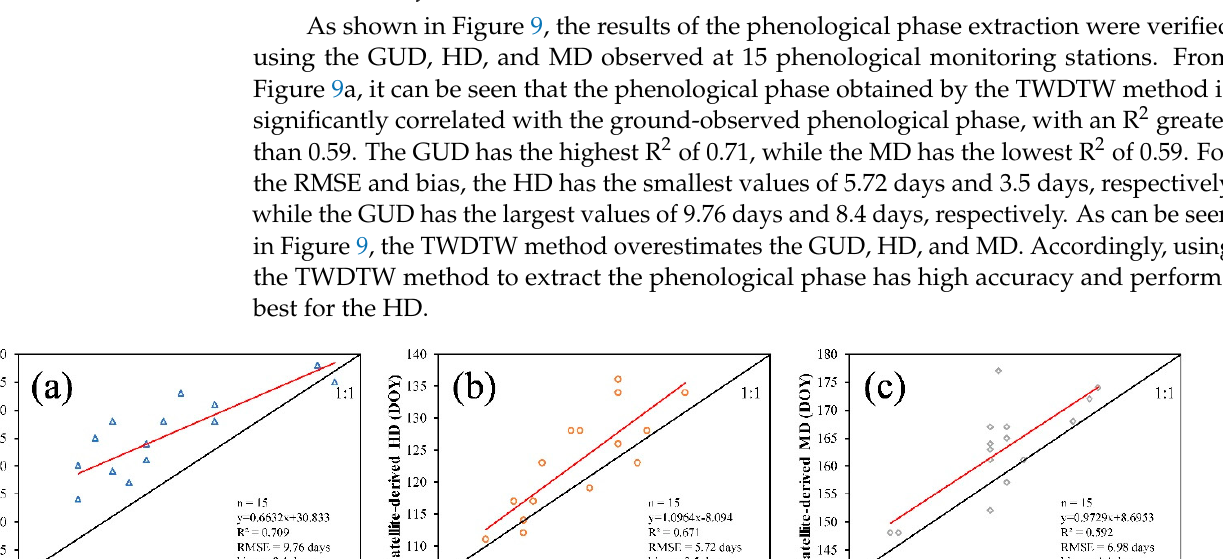
Figure 9. The validation of the satellite-derived winter-wheat phenological phases obtained using the TWDTW algorithm via comparison with ground-observed data. ( a ) GUD. ( b ) HD. ( c ) MD. The black line is the 1:1 line.